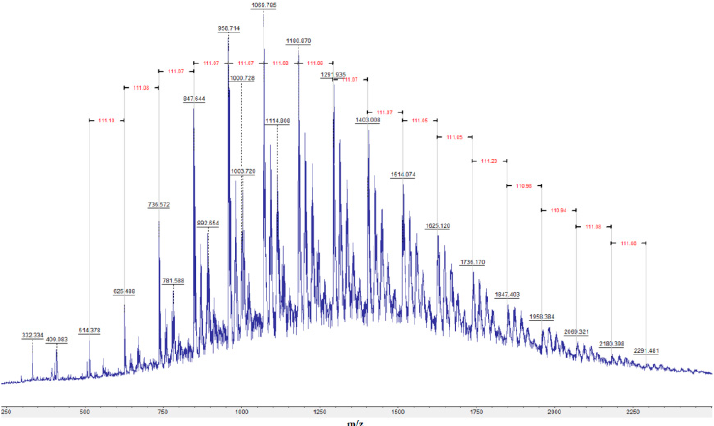
Figure 3. MALDI spectrum of an amphiphilic copolymer of N-vinyl-2-pyrrolidone and allyl glycyl ether obtained under anion detection conditions.